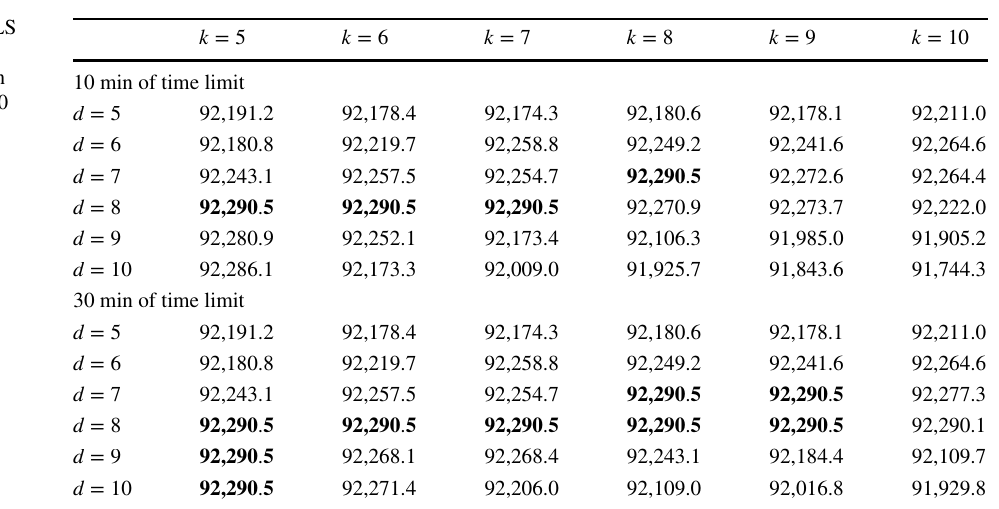
d ∈ [ 5,10 ] k ∈ [ 5,10 ] Regions of the parameters are and . Results are expressed by the average value of the best solutions of all the 30 instances obtained by the algorithms in 10 runs. Best results appear in